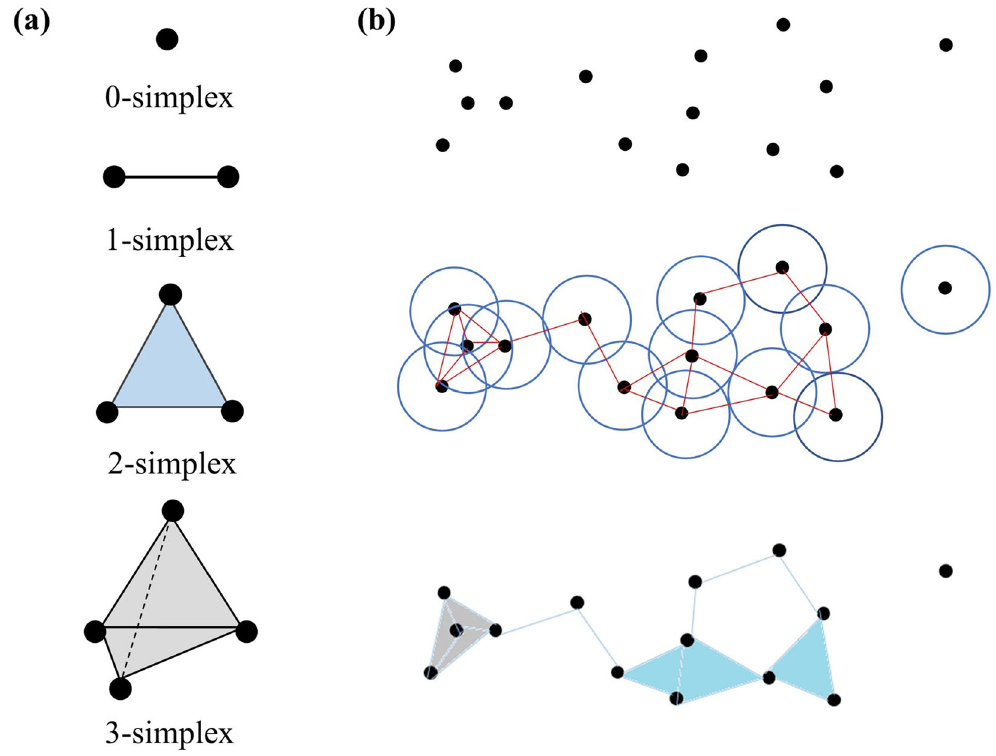
Fig. 4 Basic simplexes and simplicial complex construction in a given radius of fi ltration. a From top to bottom an example of a 0-simplex, 1-simplex, 2-simplex, and 3-simplex. b The construction of simplicial complex. There are one 0-simplex, six 1-simplexes, two 2-simplexes and one